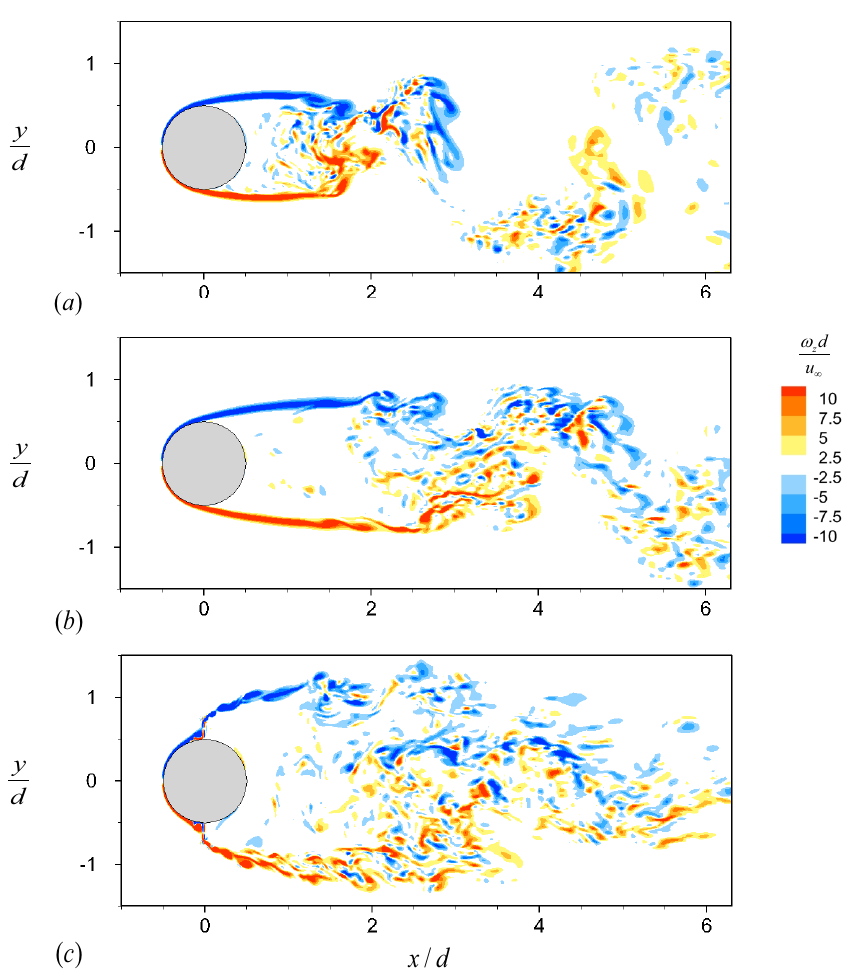
Figure 9. Instantaneous spanwise vorticity ( ω z ) contours over a circular cylinder with and without tabs on x – y planes: ( a ) cylinder without a tab; ( b , c ) cylinder with tabs of l y / d = 0.2 and l z / d = 0.3. x – y planes for ( b , c ) are z / d = 0 and z / d = 2, respectively. For ( b , c ), note that tabs are located at z / d =